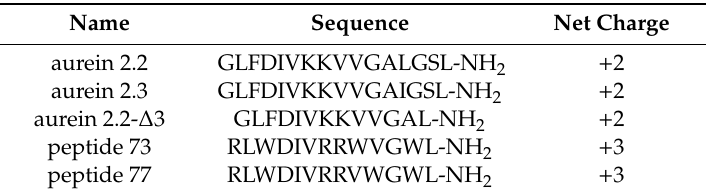
Table 2. Designed AMPs derived from the frog skin aurein